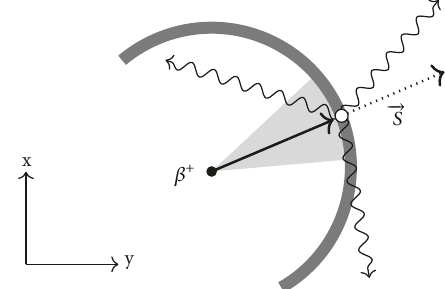
Figure 4: Determination of positron polarization axis using its momentum direction (black arrow) estimated using the 𝛽 + source position and reconstructed origin of the 3𝛾 annihilation of orthopositronium in thechamberwall (dark gray band). Theshaded regionrepresentstheangularuncertaintyofpositronflightdirection resulting from achievable resolution of the 3𝛾 annihilation point.